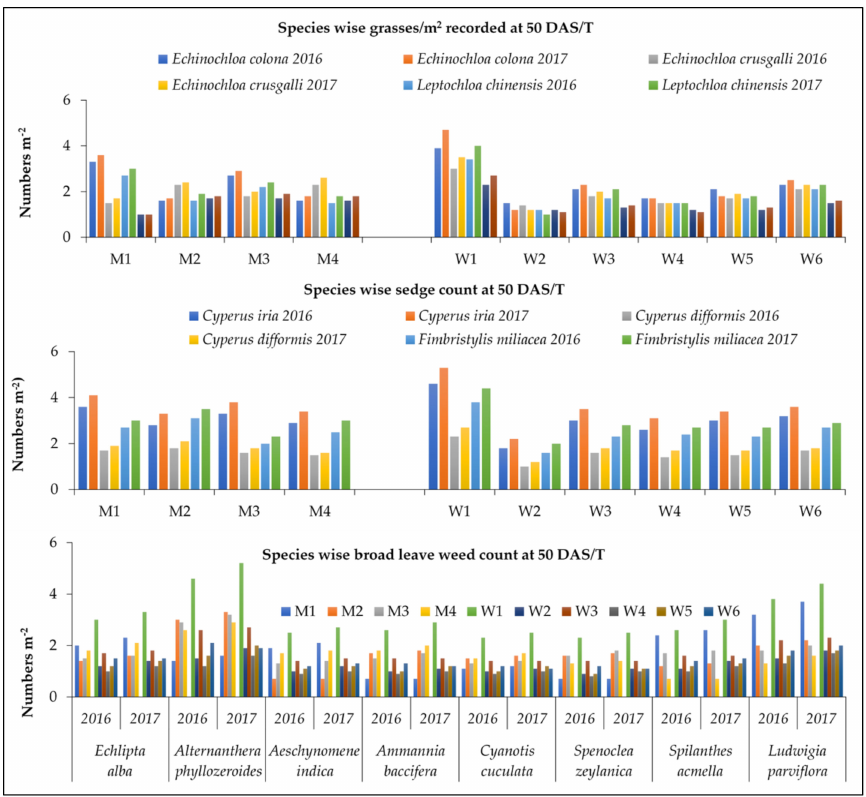
Figure 2. Effect of crop establishment methods and weed management practices on species-wise weed count at 50